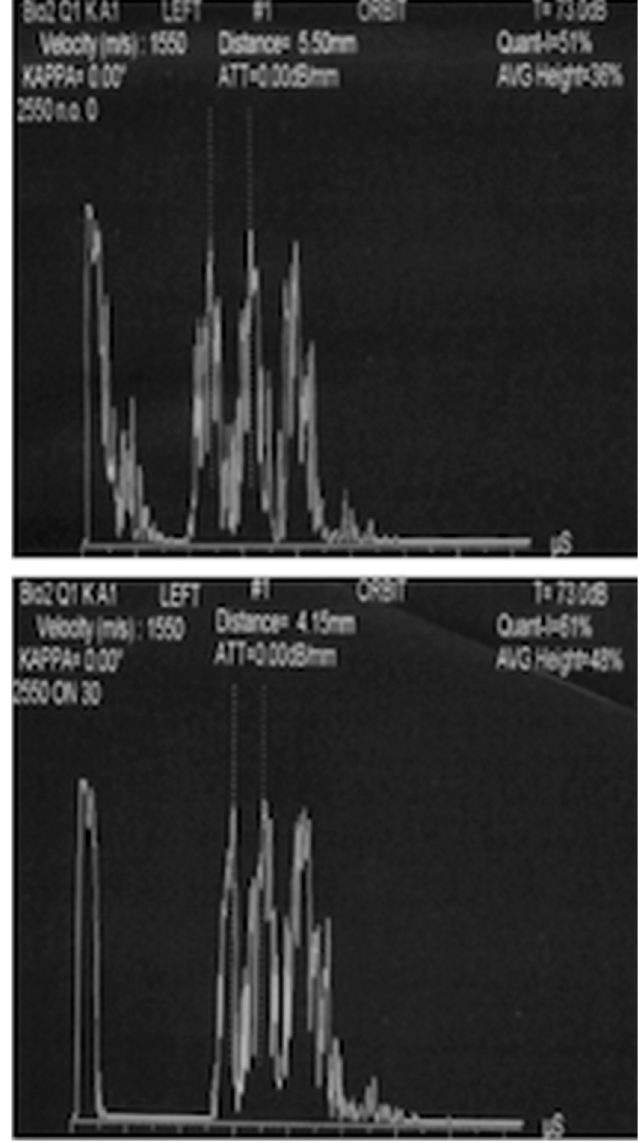
Figure 1. Standardized A-scan image of the optic nerve before (5.50 mm) and after (4.15 mm) “30 degrees test”. “30 degrees